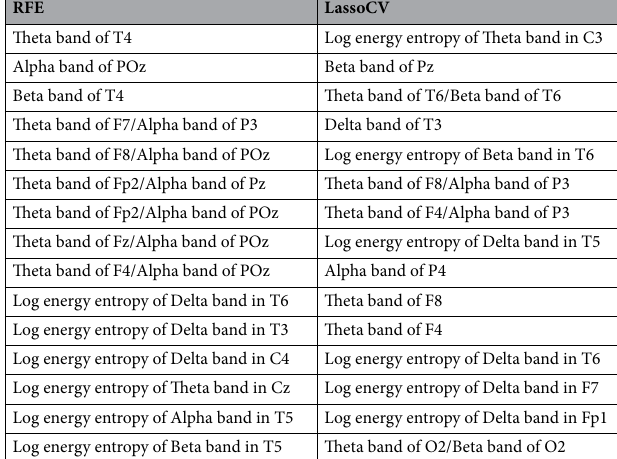
Table 1. Top fifteen Selected features using RFE and